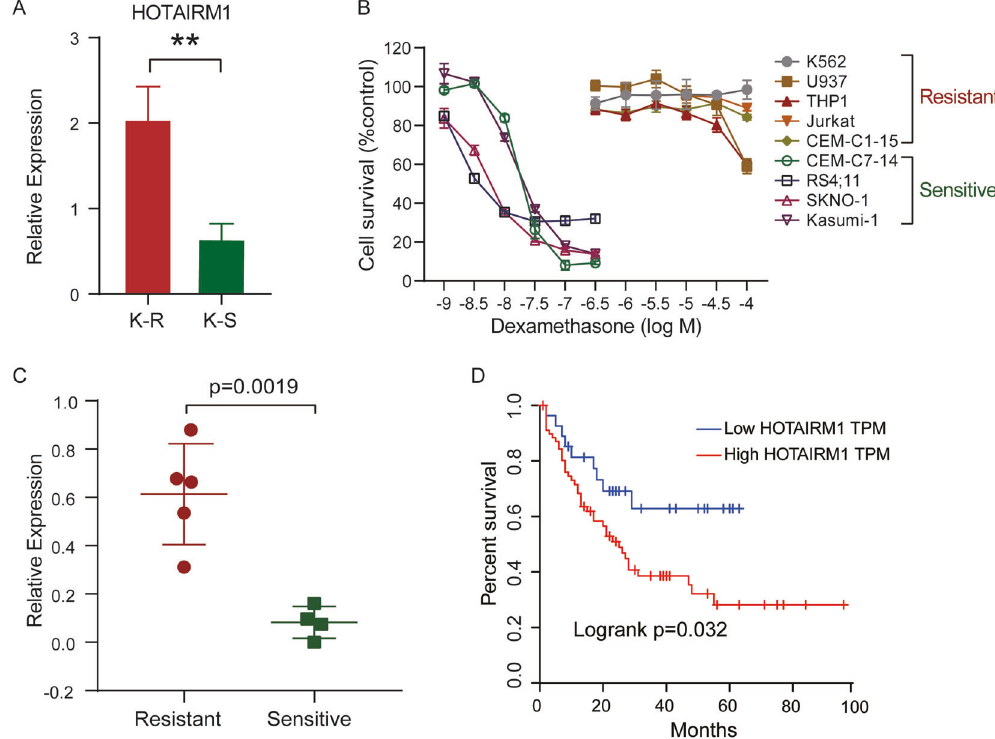
Fig. 2 High expression of HOTAIRM1 in GC-resistant leukemia cells. A The relative expression of HOTAIRM1 was measured in K-R and K-S using quantitative RT-PCR (qRT-PCR). ACTB was the reference gene. Data represent the mean ± SD of three experiments, n = 3. Difference between groups was assessed using Student ’ s t- test: * p < 0.05, ** p < 0.01, *** p < 0.001, ns means no statistical signi fi cance. B Detection of GC sensitivity among leukemia cell lines (K562, U937, THP1, Jurkat, CEM-C1-15, CEM-C7-14, RS4;11, SKNO-1, Kasumi-1). Cells were treated with various concentrations of dexamethasone for 4 days, and the cell viability was determined by MTS assay. Based on the results, these cell lines were divided into two groups: resistant cells and sensitive cells. C Relative expression of HOTAIRM1 in corresponding cells with different responses (Resistant and Sensitive) to GCs. Difference between groups was assessed using Student ’ s t -test ( p = 0.0019). D Kaplan – Meier overall survival curve of AML patients according to HOTAIRM1 expression level from TCGA data, P -value of log-rank test is